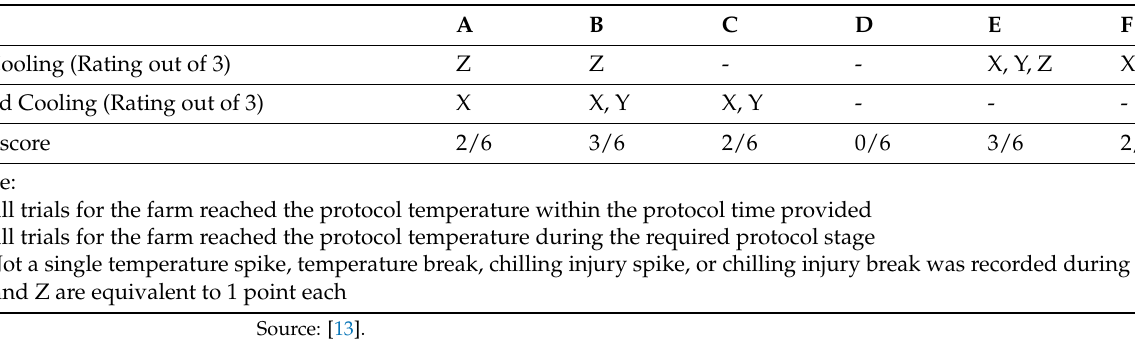
Table 5. Farm scores for effectiveness and efficiency of pre-cooling and forced